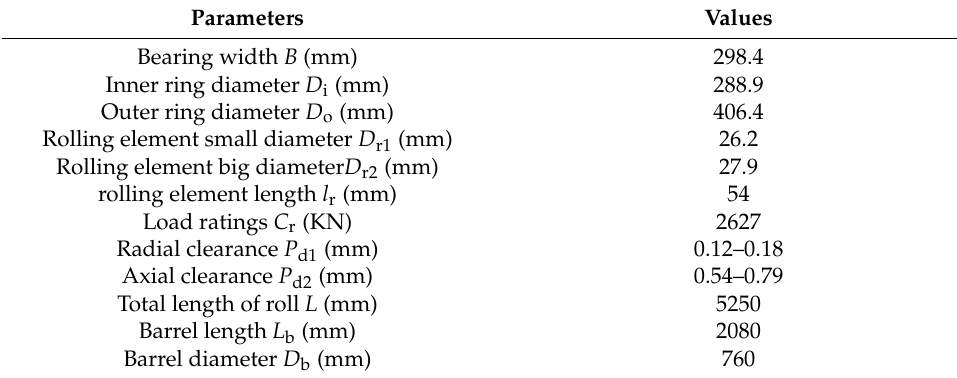
Table 1. Structural parameters of the RBBH system.